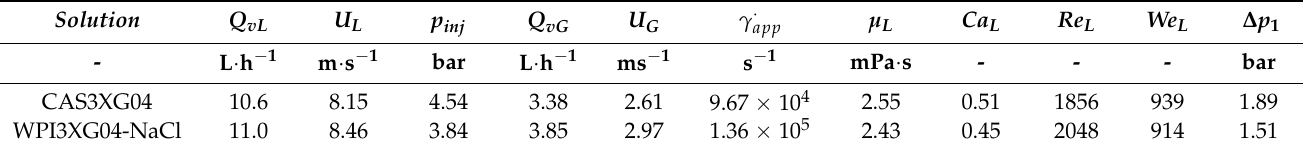
Figure 16. Properties of bubbles flowing through several liquid bases inside the mixing channel of the device CX600 at Q vL = 11 L · h − 1 − Q mG = 21.6 g · h − 1 . ( a ) Sauter diameter. ( b ) Circularity. ( c ) Average bubble speed. ( d ) Bubbling frequency. The liquid flowrate for CAS3XG04 was slightly lower (conditions for CAS3XG04 were Q vL = 10.6 L · h − 1 − Q mG = 21.6 g · h − 1 ). Table 8. Hydrodynamic parameters of the two-phase flow in the mixing channel of the microfluidic device CX600 for